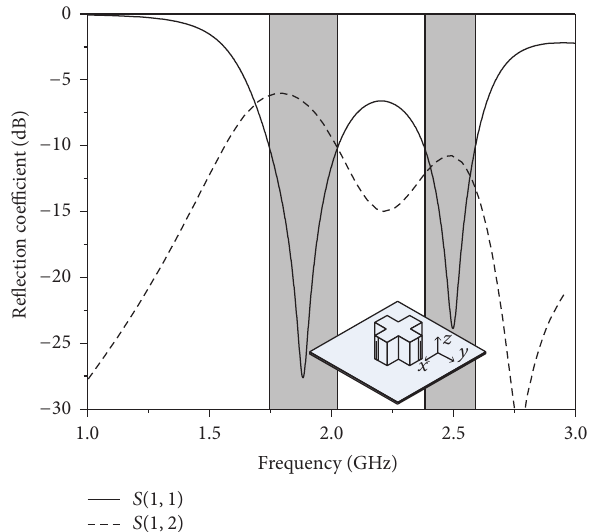
Figure 4: Simulated reflection/isolation coefficient with a perturbation in DRA shape.